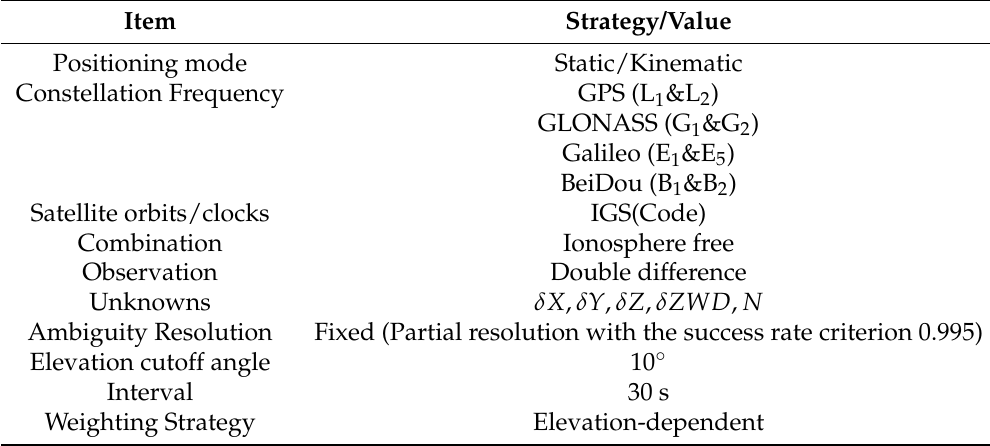
Figure 1. Position of the stations with their heights. Table 1. Summary of the strategy of data